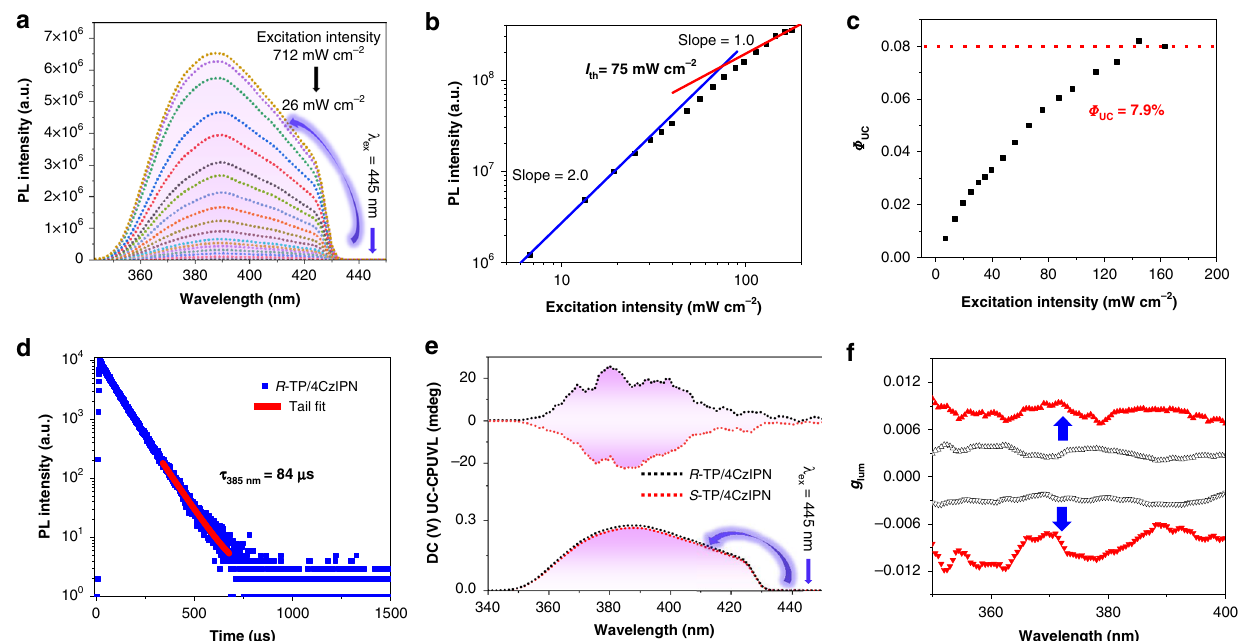
Fig. 3 Upconversion and UC-CPUVL process of R ( S )-TP/4CzIPN in deaerated toluene solution. a Upconversion emission spectra of R -TP/4CzIPN with different incident excitation intensities of the 445 nm CW laser in deaerated toluene solution. b Double-logarithmic plots of the upconversion emission intensity of R -TP/4CzIPN in deaerated toluene solution as a function of the excitation intensity. c Upconversion ef fi ciencies of R -TP/4CzIPN in deaerated toluene solution with different excitation light intensities of the 445nm CW laser. d Time-resolved upconverted emission at 385 nm of the R -TP/4CzIPN in toluene solution ( λ ex = 445nm). e UC-CPUVL spectra of R -TP/4CzIPN and S -TP/4CzIPN in deaerated toluene solution ( λ ex = 445 nm). f Luminescence dissymmetry factor g lum of UC-CPUVL versus wavelength. R -TP/4CzIPN excited by 445 nm CW laser (red triangle); R -TP excited by 290 nm (white triangle); S -TP/4CzIPN excited by 445 nm CW laser (red inverted triangle); S -TP excited by 290 nm (white inverted triangle). ([ R -TP] = [ S -TP] = 3